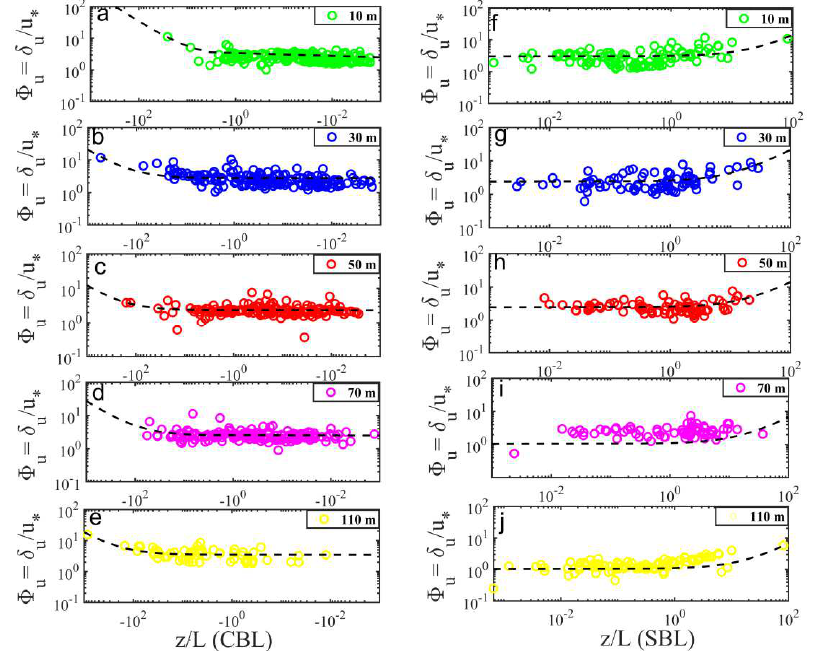
Figure 4. Plots of the normalized standard deviations of the longitudinal wind velocity components ( σ u / u ∗ ) in log-log scales versus the stability parameter ( z / L ) under unstable (or CBL, <0,) and stable (or UBL, ζ > 0) stratification conditions for the 10-min-averaged onshore data collected during Typhoon Maria’s landfall (10–12 July 2018). The black dashed lines correspond to ϕ u ( ζ ) = 1.1 ( 10 − 1.56 ζ ) 1/3 for ζ < 0 and ϕ u ( ζ ) = ( 1 + 1 ζ ) 1/3 for ζ > 0 (Kaimal and Finnigan [39]).